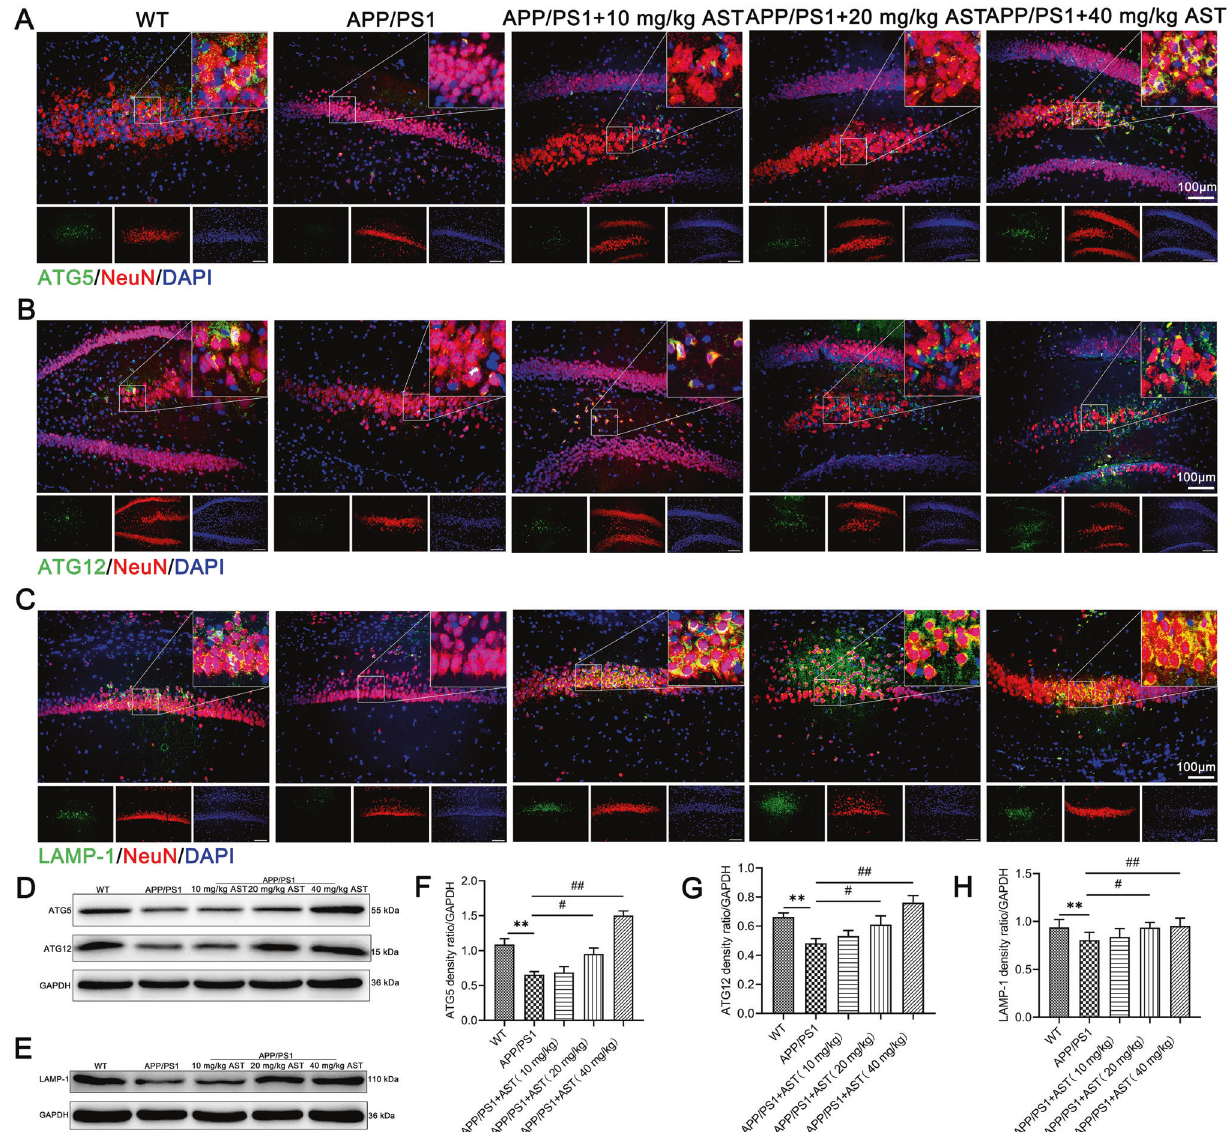
Fig. 5 AST promoted autophagosome formation and the initiation of autophagic lysosomal phase in hippocampal neurons of APP/PS1 mice. A – C Representative immuno fl uorescent staining of ATG5/ATG12/LAMP-1, NeuN, and DAPI in hippocampal neurons of mice. Scale bar = 100 μ m. D , E Representative bands of ATG5, ATG12, and LAMP-1 in the hippocampus of mice by WB detection. F – H Statistical analysis of ATG5, ATG12, and LAMP-1 proteins in the hippocampus of mice. Data were presented as mean ± SD, n = 3/group. ** p < 0.01 vs WT group, # p < 0.05, ## p < 0.01 vs APP/PS1